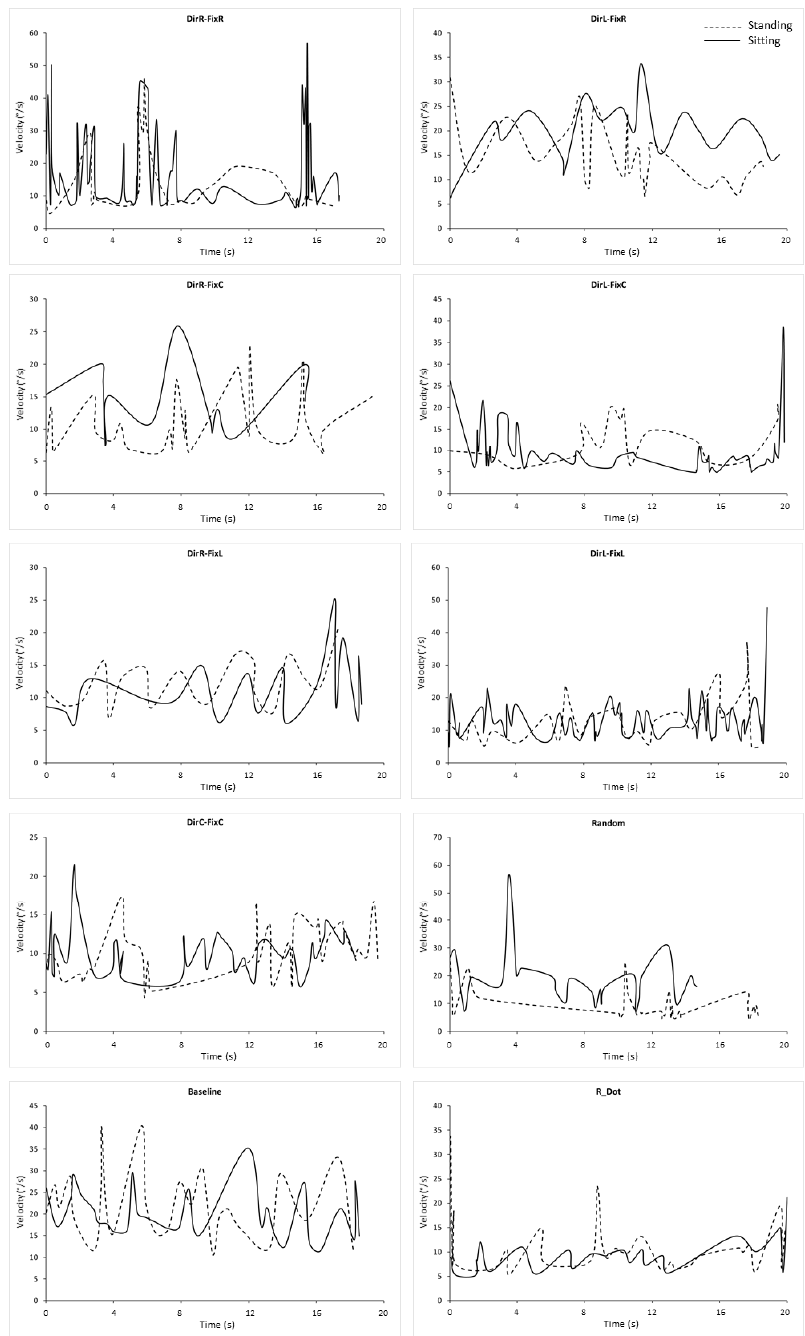
Figure 2. Waveforms of microsaccade velocity in all stimuli in both conditions. Each line in each diagram represents the waveform of all microsaccades recorded in an exemplary subject and trial. DirR-FixR: subject 10, trial 1. DirL-FixR: subject 16, trial 5. DirR-FixC: subject 05, trial 3. DirL-FixC: subject 19, trial 2. Baseline: subject 03, trial 1. DirR-FixL: subject 18, trial 1. DirL-FixL: subject 10, trial 3. DirC-FixC: subject 05, trial 3. Random: subject 06, trial 4. Baseline: subject 03, trial 1. R_Dot: